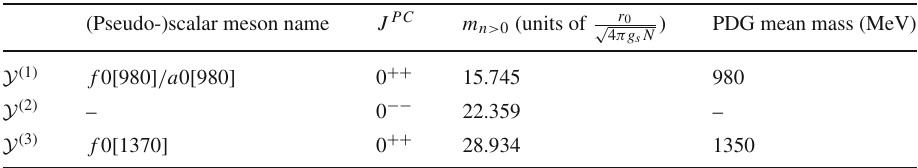
Table 6 (Pseudo-)scalar meson masses from WKB quantization